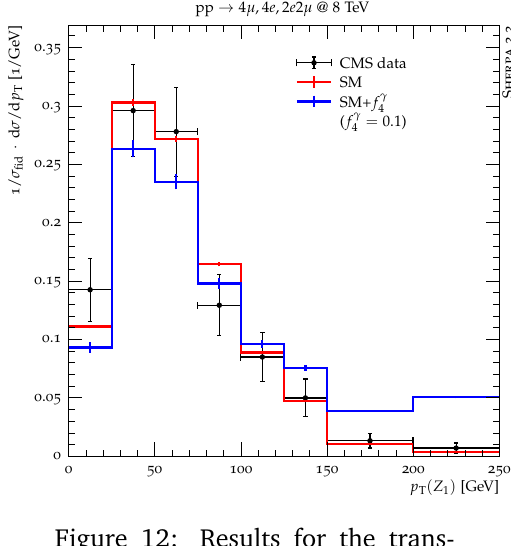
Figure 11: Prediction for the expected number of events with > S min S in inclusive five-jet pro- T T duction in proton-proton collisions (cid:112) s = 100 TeV. at